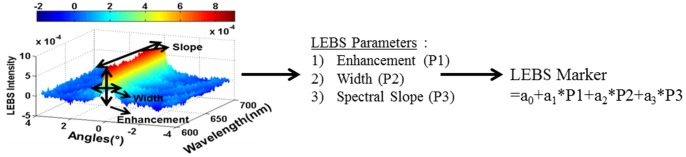
Representative image of LEBS peak from intact rat tissue.LEBS images show the different parameters (E, W & S) calculated from this peak and the scheme for calculation of LEBS marker using logistic regression of LEBS parameters by linear combination.